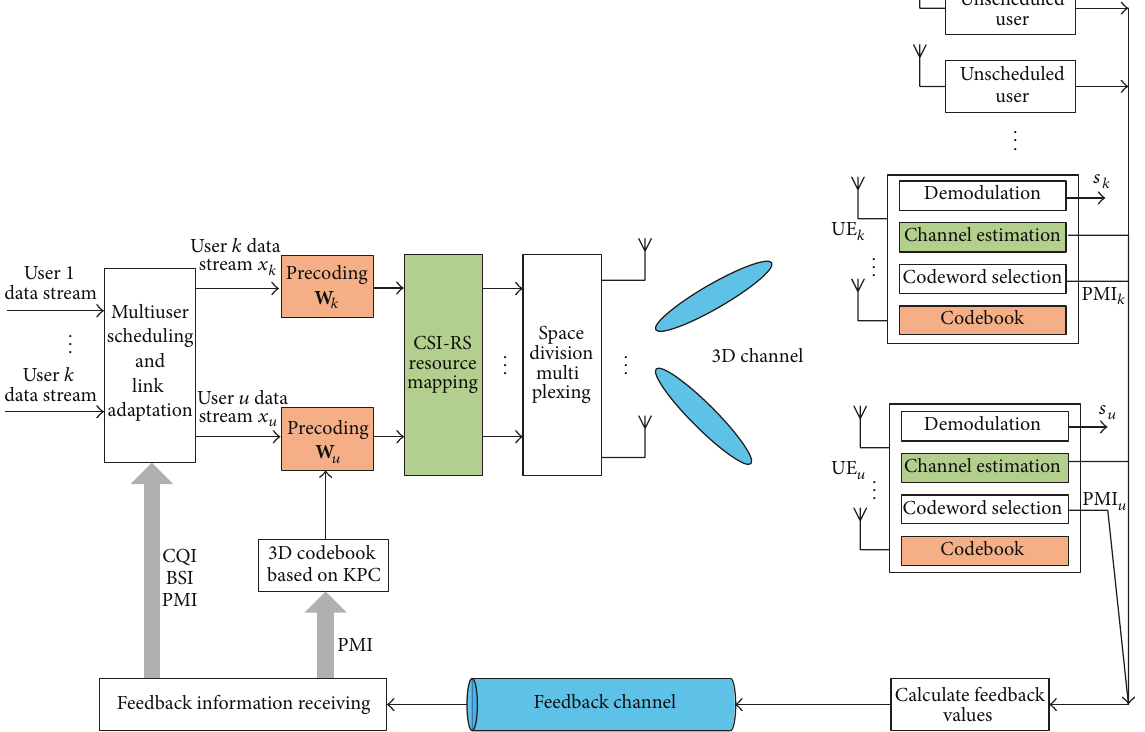
Figure 3: Block diagram of the 3D MU-MIMO downlink transmission